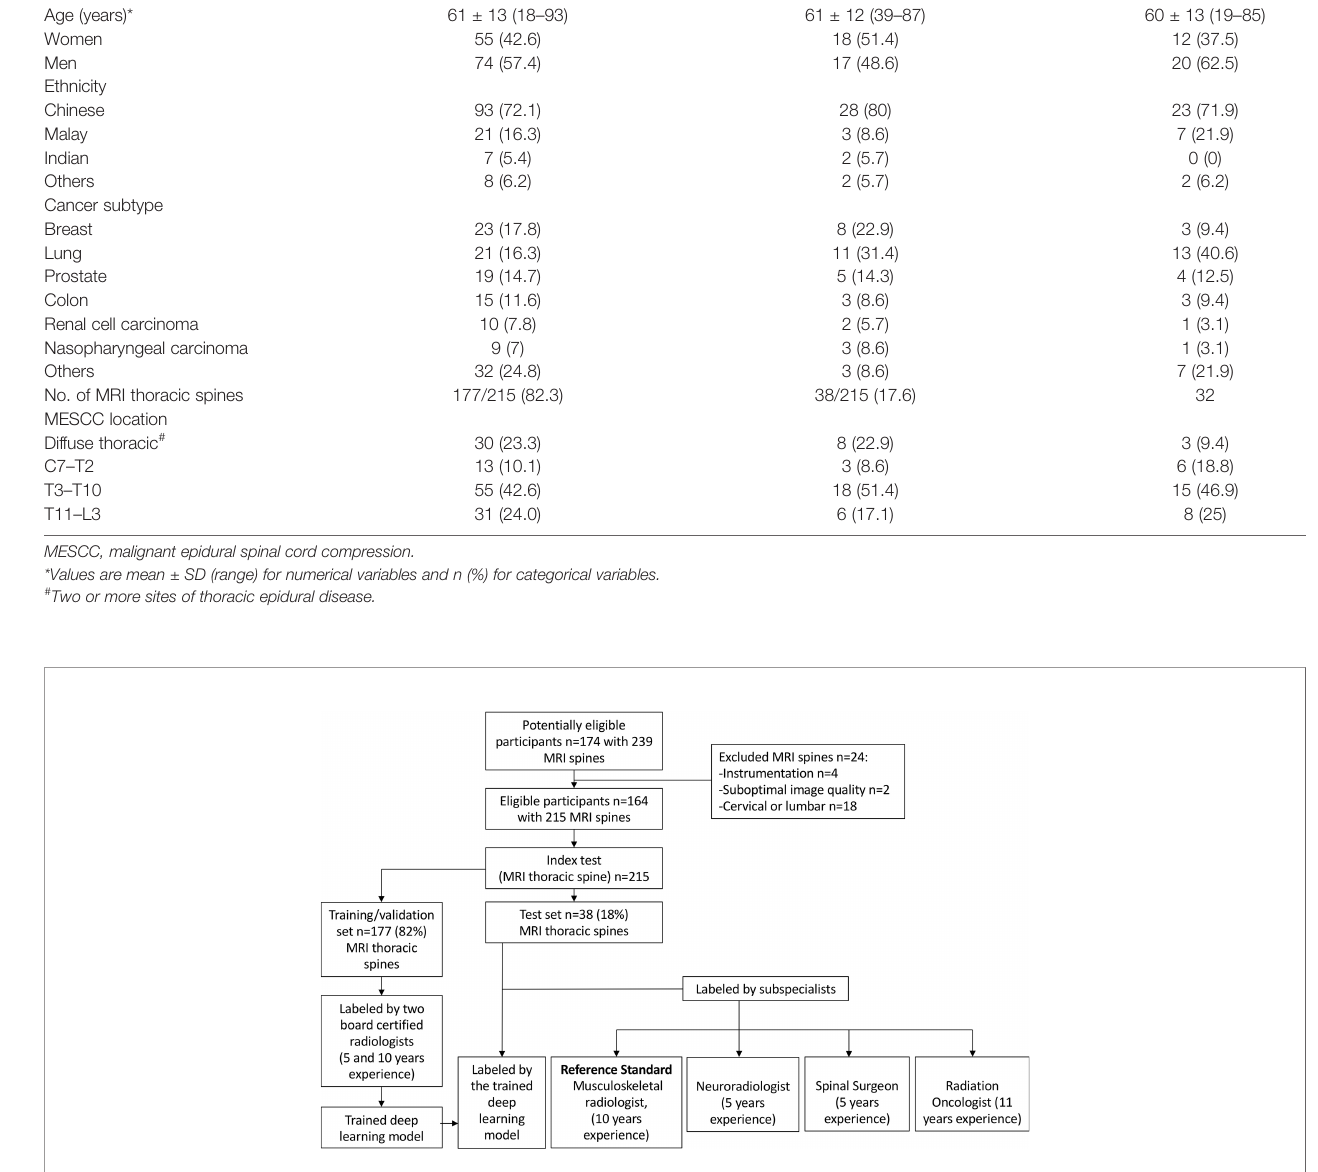
FIGURE 2 | Flow chart of the study design for the internal training/validation and test sets. The deep learning model performance was compared with an expert musculoskeletal radiologist (reference standard) and three specialist readers.